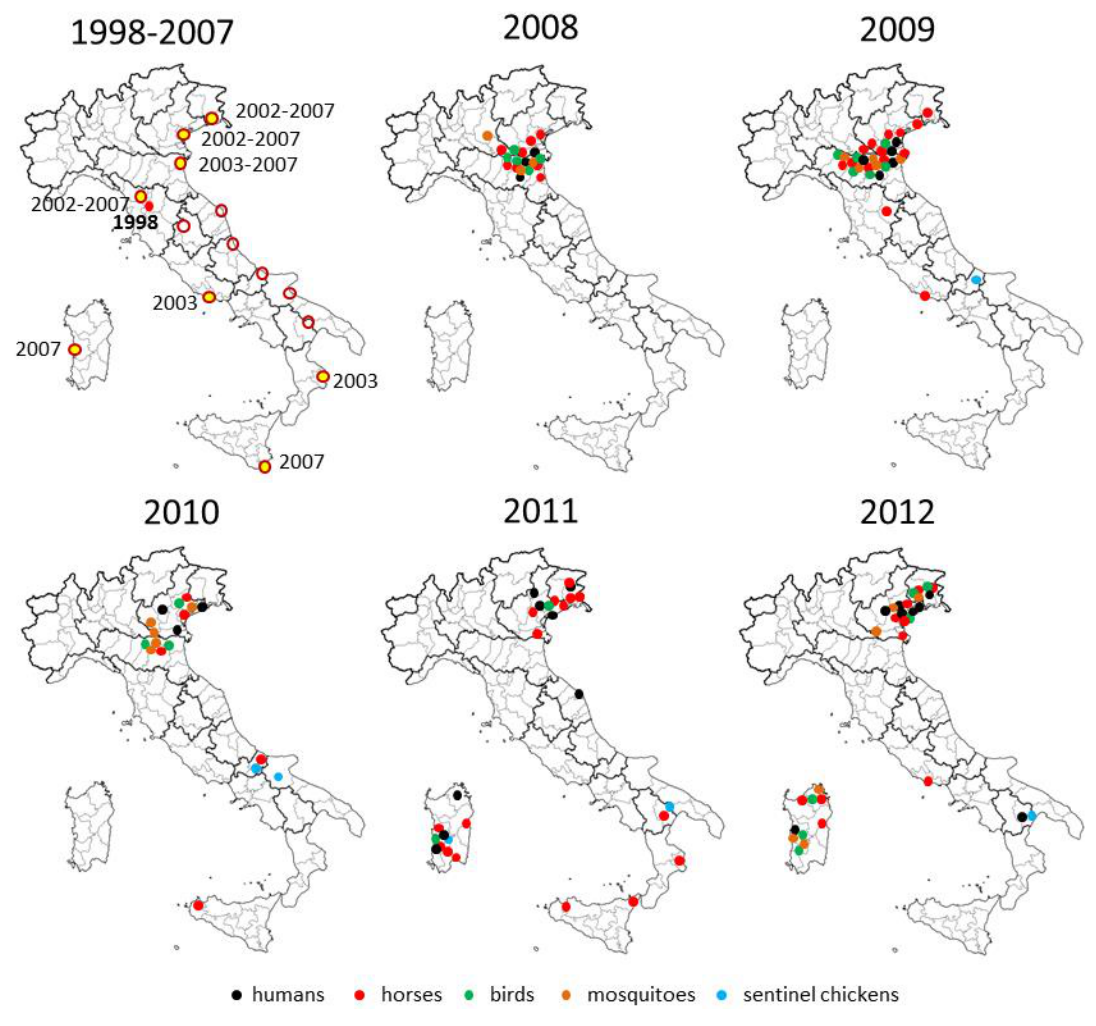
Figure 1. Maps of WNV activity and surveillance results in Italy, 1998–2012. In the map of the years from 1998 to 2007, wetland areas under surveillance for WNV infection are represented with circles; areas where seroconversions of anti-WNV IgGs in sentinel horses and/or chickens were detected are highlighted in yellow and the years reported. In the maps of the years from 2008 to 2012, areas involved by WNV activity, i.e. , human and equine cases of WNV disease, WNV detection in birds and mosquitoes, and seroconversion in sentinel chickens, are indicated with